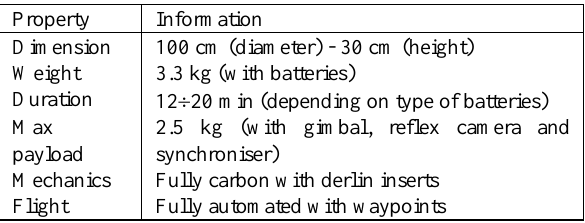
Table 5 Technical information about the UAV esacopter, model Esafly 2500 by SAL Engineering , used at St. Stefano Basilica.